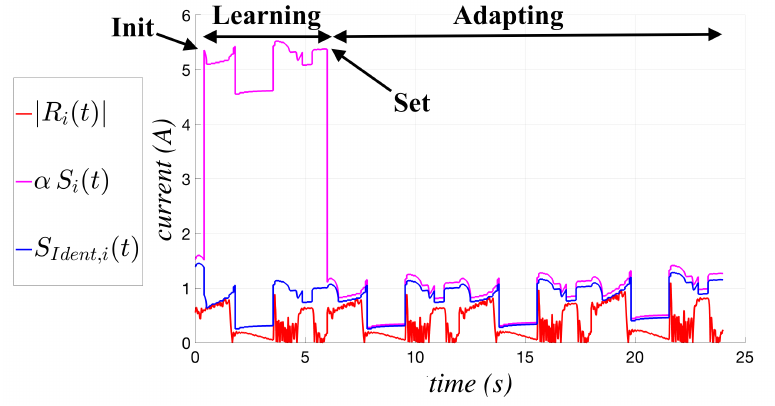
Figure 11. Example of a cycle involving init, learning, set and adapting